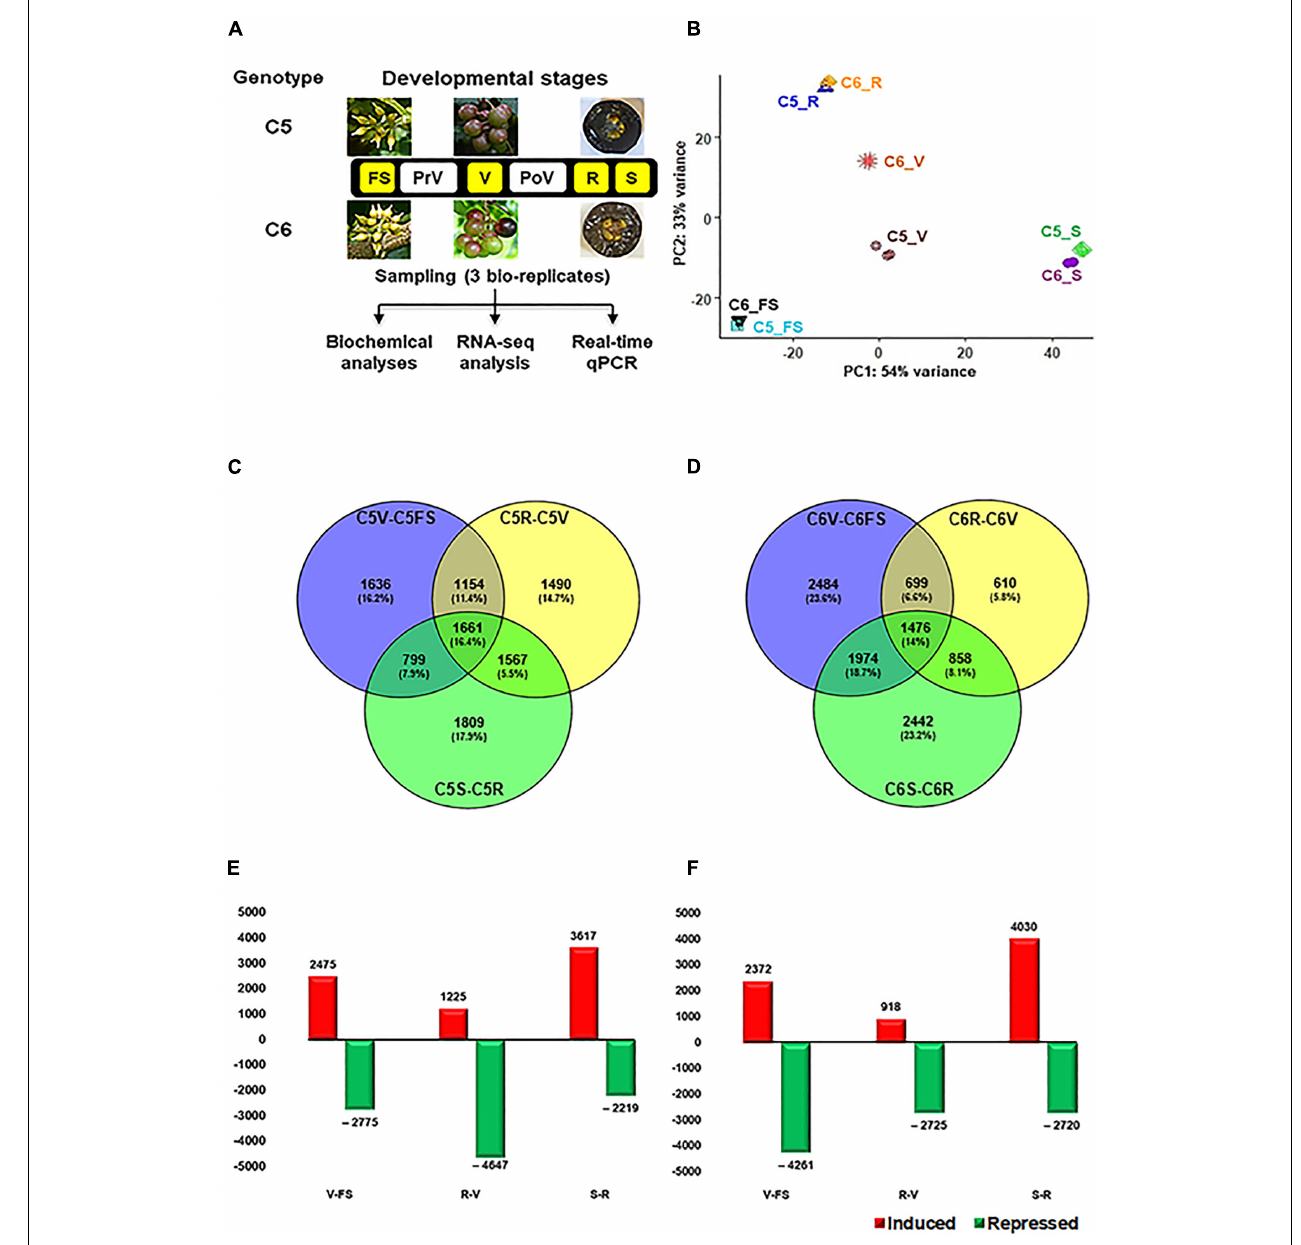
FIGURE 1 | Overall experimental procedure of muscadine berries. (A) The layout of the study used the two muscadine genotypes, C5 (C5-9-1) and C6 (C6-10-1), exhibiting differential phenolic/flavonoid levels and antioxidant activity profiles (Darwish et al., 2021). The developmental stages highlighted in yellow represent the samples selected for RNA-seq, including fruit-set (FS), véraison (V), ripe skin/flesh (R), and ripe seeds (S). However, pre- and postvéraison stages (PrV and PoV) were only included in the quantitative PCR (qPCR) assay. (B) The principal components analysis (PCA) of the samples’ replicates, where normalized counts were transformed to the variance stabilizing transformation (VST) using DESeq2. Each unique combination of a developmental stage was given a distinctive color. (C,D) By using DESeq2 and EdgeR pipeline, each stage was compared to its preceding one within the same genotype. As a result, 10,116 and 10,543 non-redundant differentially expressed genes (DEGs) were identified in C5 and C6, respectively, with fold2change > ± 1.5. (E,F) Bar plot of DEGs in C5 and C6 when each stage was compared to its former